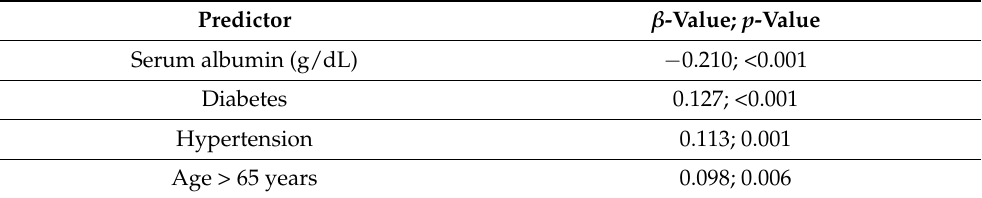
Table 3. Multiple linear regression analysis on independent predictors of hospital length of stay.